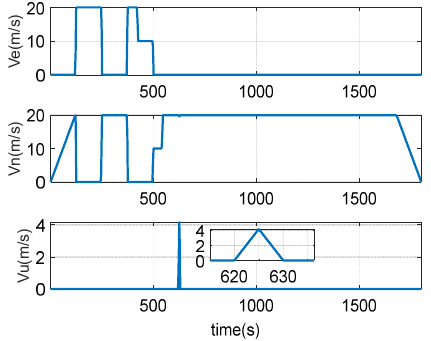
Figure 8. Vehicle speed change of the vehicle.